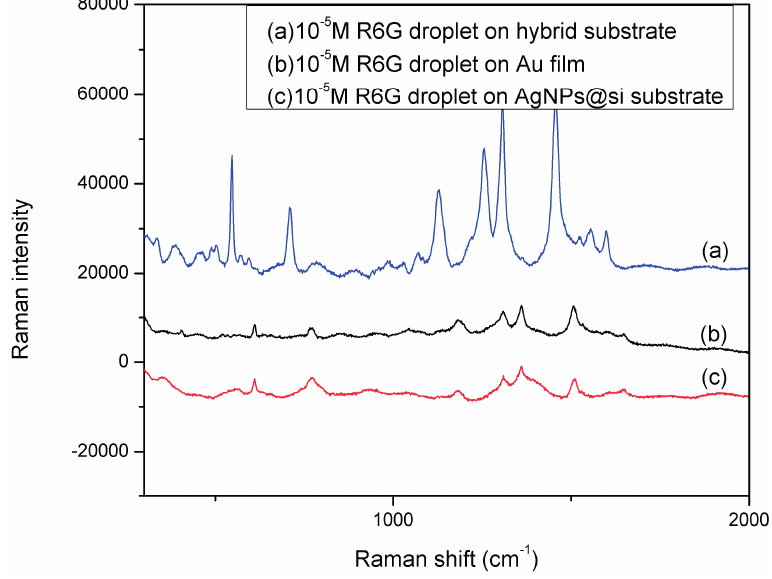
Figure 6. The Raman spectra of R6G measured on different